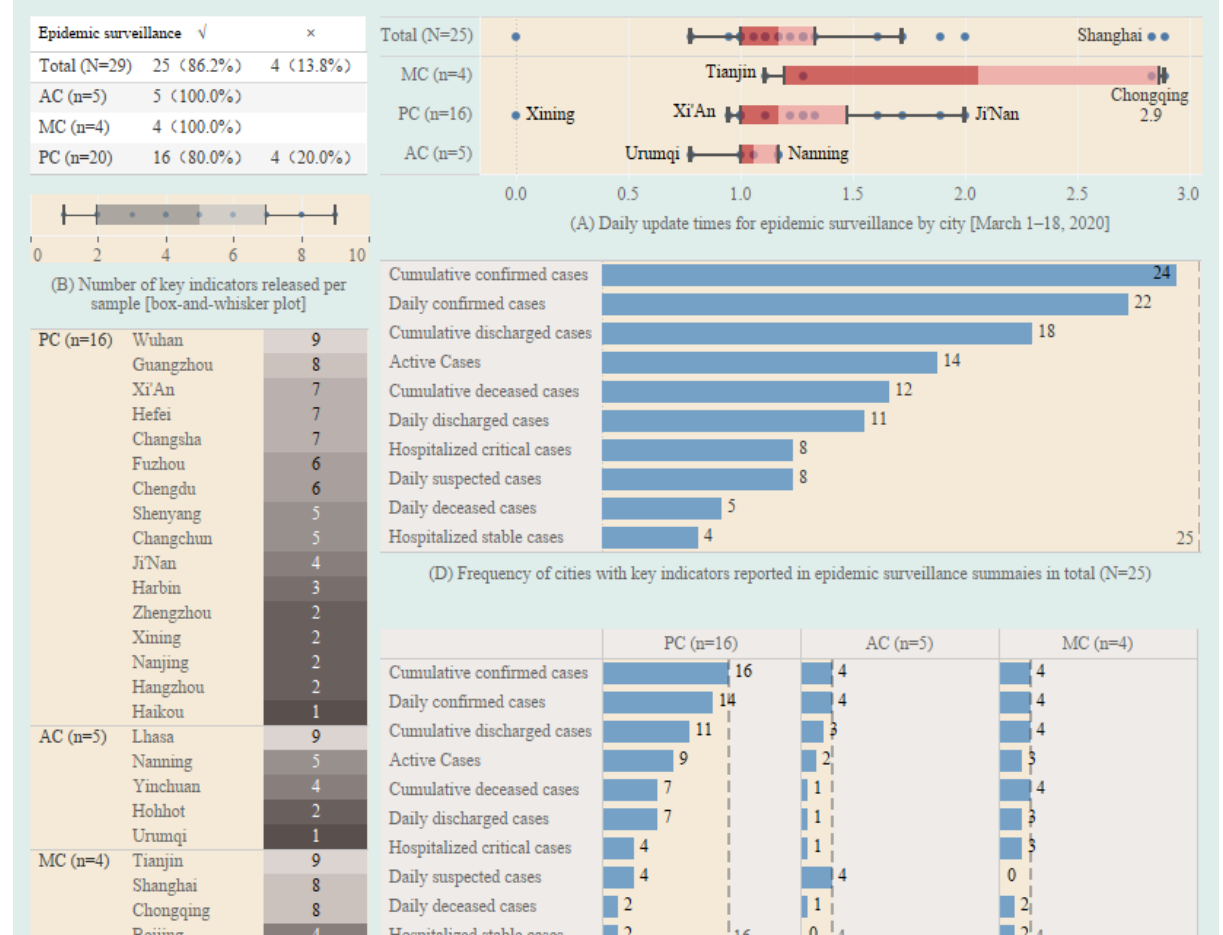
Figure 3. Key indicators reported in epidemic surveillance summaries as of March 18, 2020. (A) Daily update times for epidemic surveillance by city from March 1 to 18, 2020; distribution was reported using a box-and-whisker plot; blue dots with black text labels indicate maximums and minimums. (B) Number of key indicators released per sample; distribution was reported using a box-and-whisker plot. (C) Number of key indicators released by city; distribution was reported by heatmap. (D) Frequency of cities with key indicators reported in epidemic surveillance summaries in total (N=25). (E) Frequency of cities with key indicators reported in epidemic surveillance summaries by city type. AC: autonomous region capital; MC: municipality directly administered by the central government; PC: provincial